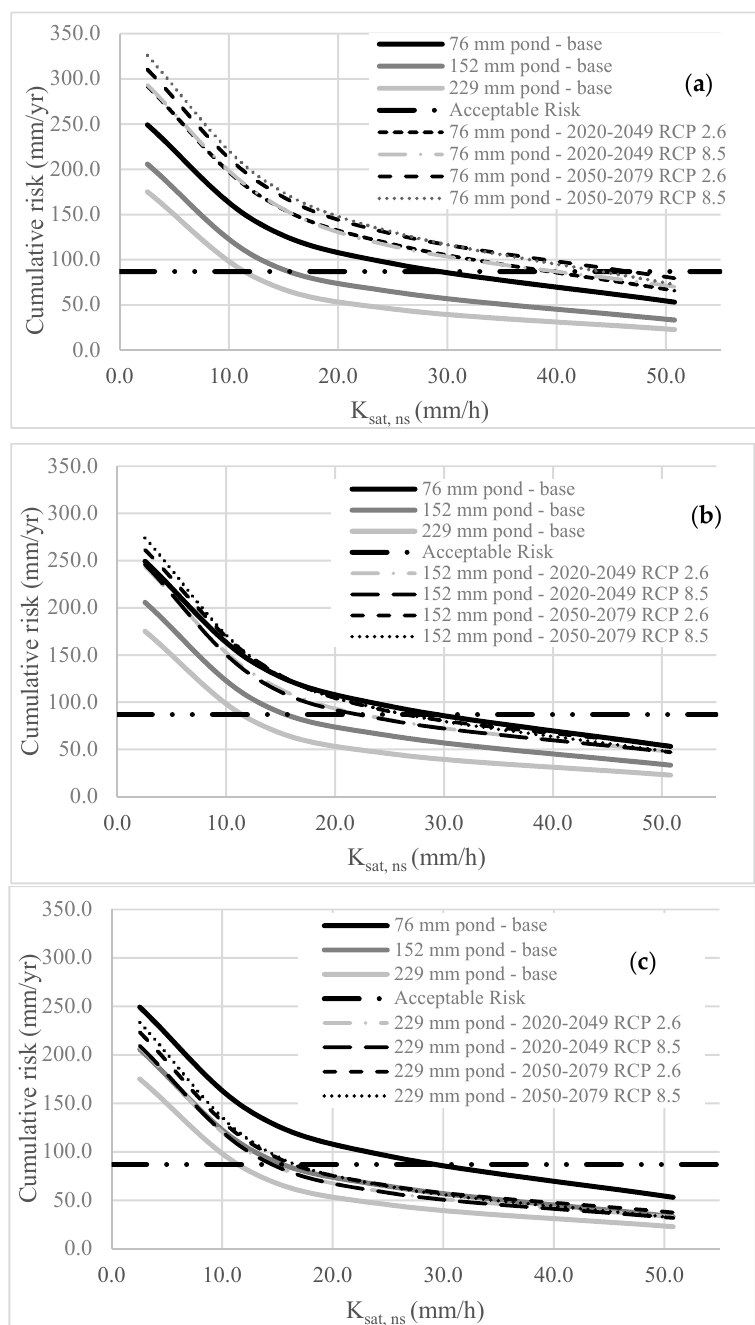
Figure 3. Cumulative risk for climate change scenarios based on K sat, ns compared to cumulative risk and predevelopment conditions for bioinfiltration designs with: ( a ) 76 mm of ponding, ( b ) 152 mm of ponding, and ( c ) 229 mm of ponding.